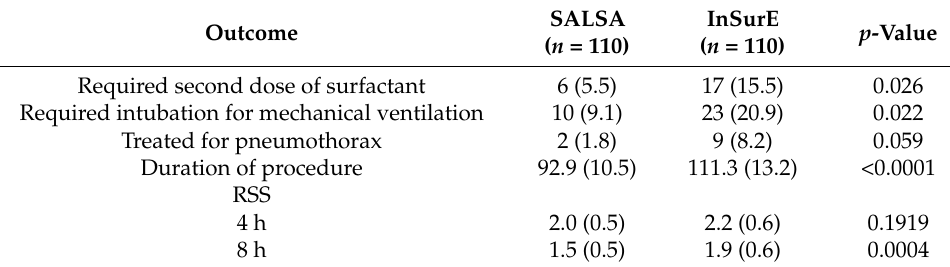
Table 2. Study Outcome